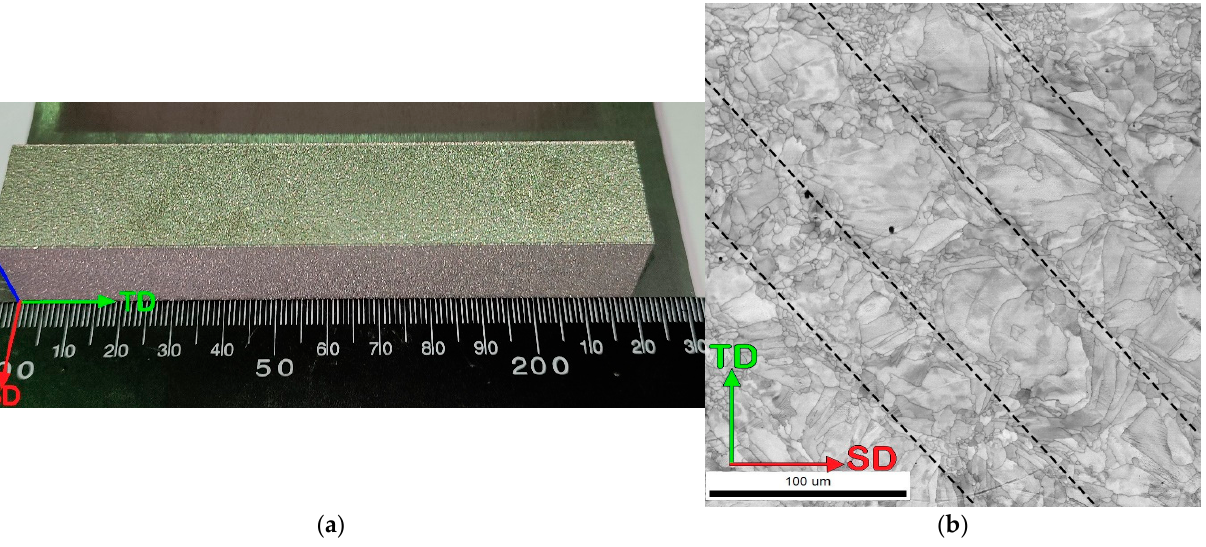
Figure 6. Photograph ( a ) and microstructure (EBSD image quality (IQ) map) ( b ) of the as-produced (mode: P = 200 W and V = 1600 mm/s) Fe 65 (CoNi) 25 Cr 9.5 C 0.5 alloy specimen (the black dotted lines indicate the laser beam tracks).